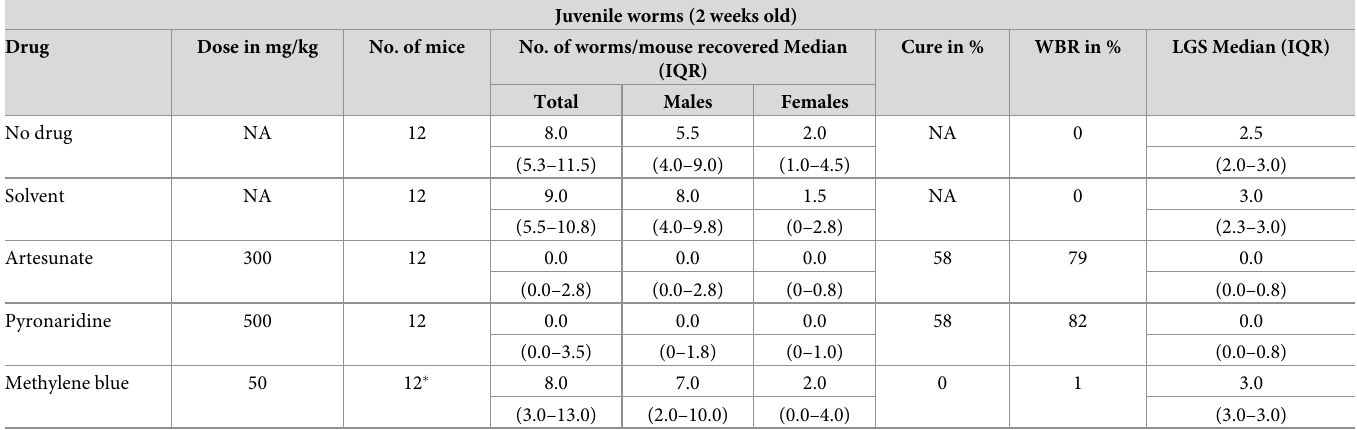
Table 3. Activity against juvenile S . mansoni in mice.